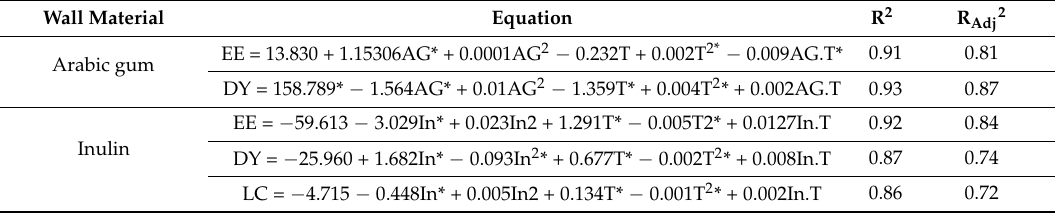
Table 2. Regression coefficients of second-order polynomial equations for each response variable.